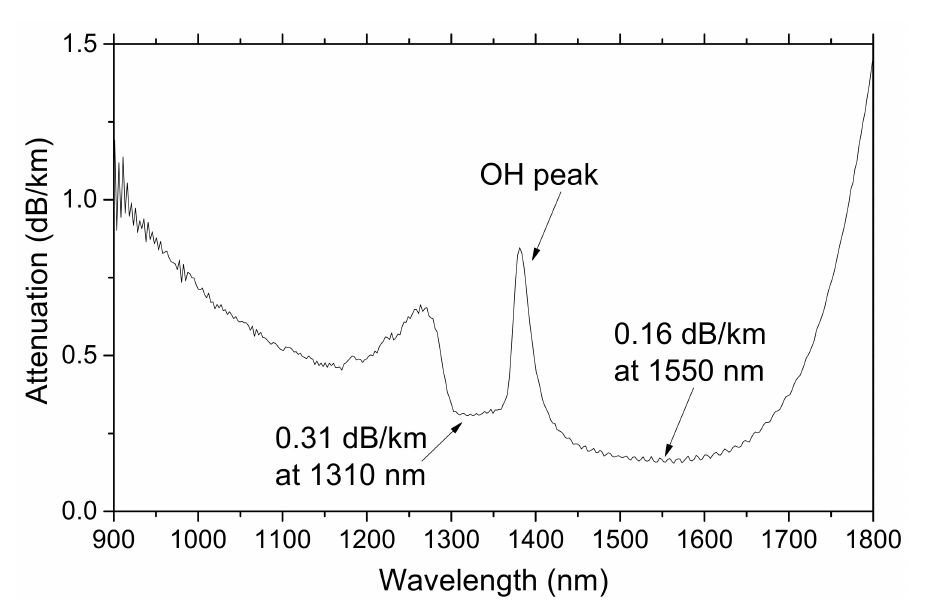
Figure 1. Spectral attenuation of the tested ultra-low loss pure silica core (ULL-PSC) fiber before